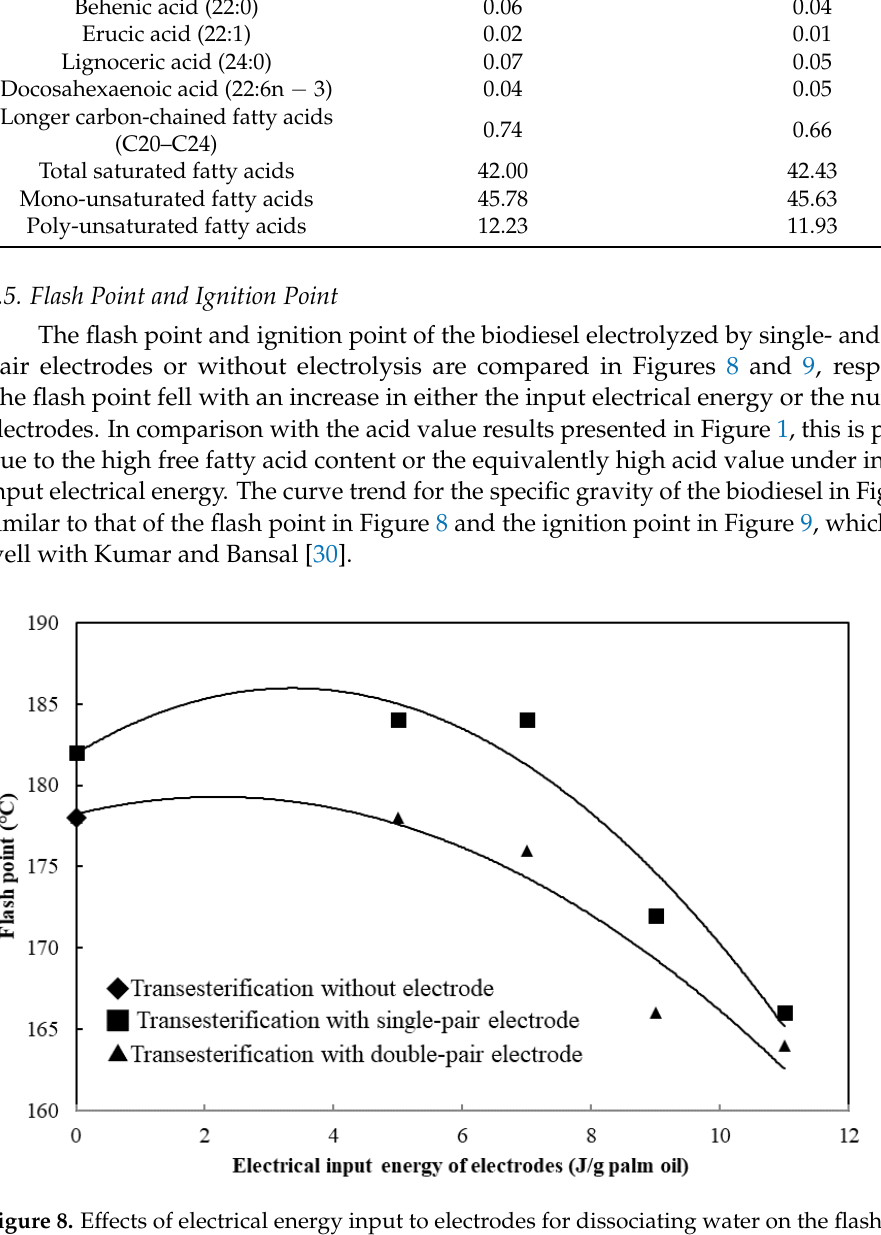
Figure 8. Effects of electrical energy input to electrodes for dissociating water on the flash point of biodiesel product.